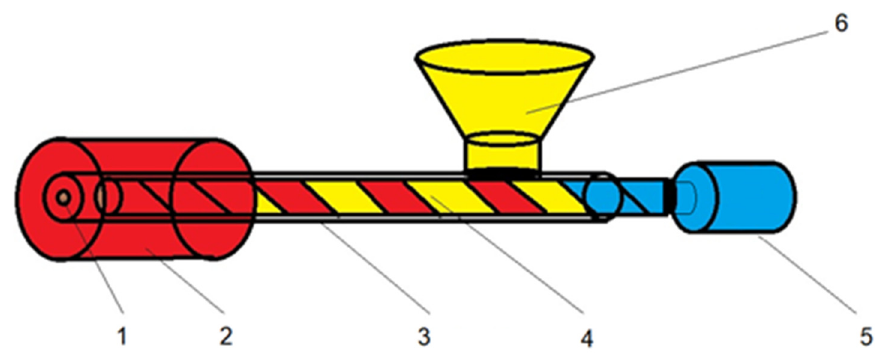
Figure 1. Operating scheme of the horizontal prototype hot-melt extruder (1—extrusion nozzle; 2—heated element; 3—extrusion barrel; 4—extrusion screw; 5—geared motor; 6-loading funnel).